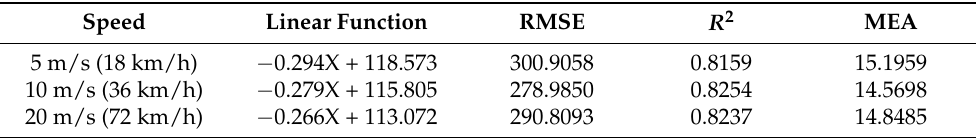
Table 9. The effect of the flight terrain on the performance; the results are presented for location #2 and an altitude of 200 m, at various speeds.